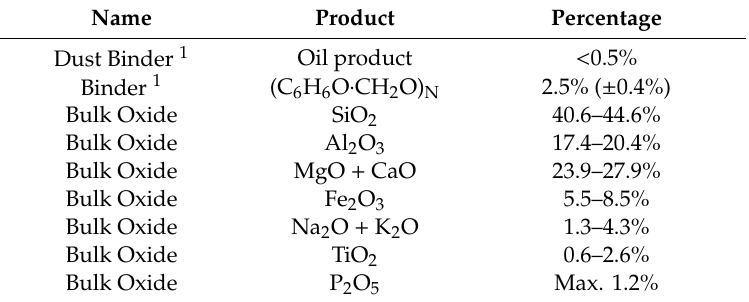
Table A3. Data for the thermal insulation studied (Rockwool ProRox PSM 971. 50 mm)